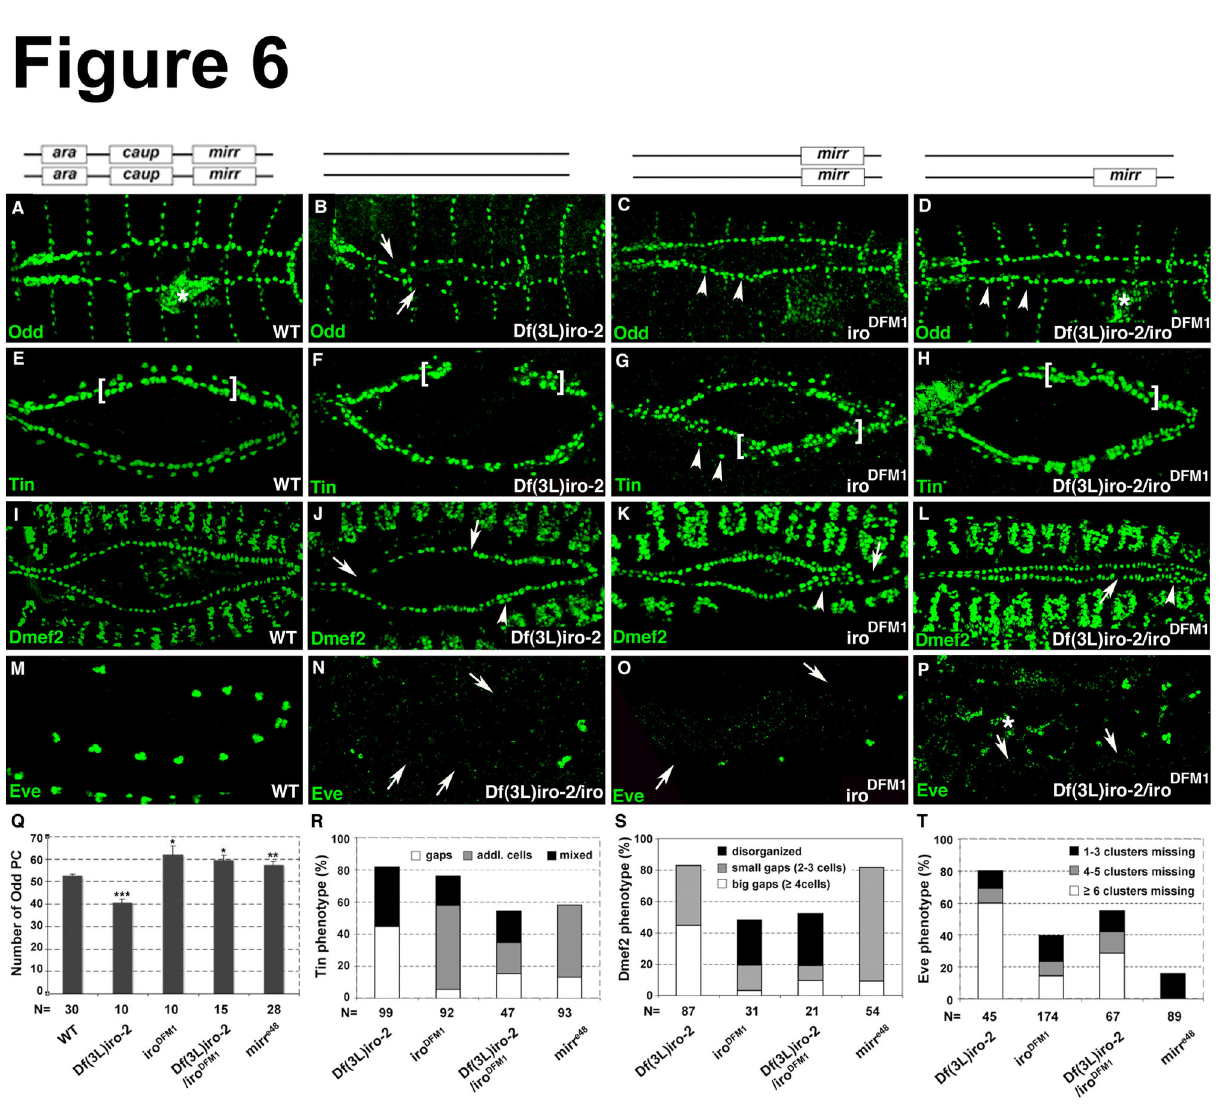
Figure 6. Heart phenotypes embryos mutant for Iro-C . The genetic background is depicted in the drawing above each column. The boxes illustrate the presence of the indicated factor. (A-D, Q) Loss of ara/caup results in an increase in Odd-expressing pericardial cells (arrowheads in C, D), whereas embryos carrying the larger deletion exhibited a reduced number of Odd-positive cells (arrows in B). Asterisks in A and D demarcate Odd expression in the gut. Q) The numbers of Odd-positive cells in each Iro-C mutant were statistically tested for significant differences from wild-type embryos using the Mann-Whitney test (* p < 0.01, ** p < 0.001, *** p < 0.0001). Odd-positive cells that are part of the lymph glands were not included in the counting. (E-H) Iro-C mutants exhibit an abnormal pattern of Tin-expressing cells. The brackets highlight some hemisegments in which the normal pattern of four Tin-positive myocardial cells and two Tin-expressing pericardial cells is disorganized. The arrowheads in G point to Tin-positive cells that are detached from the heart. (I-L) Phenotypes for Dmef2 varied in their severity and included loss of Dmef2-positive cells (arrows) as well as misalignment of the two myocardial cell rows (arrowheads). (M-P) Loss of Iro-C results in a reduction of Eve clusters. (R-T) Quantification of the phenotypes observed. The bar graphs depict the percentage of embryos that exhibited a particular phenotype for the indicated marker. All embryos are oriented with the anterior to the left. Dorsal views of embryos at stages 14-16 are shown in A-L. Lateral views of embryos at stages 10/11 are shown in M-P. doi: 10.1371/journal.pone.0076498.g006 disorganization after overexpression of either UAS- caup or cells (Figure S3E, G, H). As to Tin, the phenotype is a dramatic UAS- mirr (Figure S3I, K, L). Interestingly, overexpression of